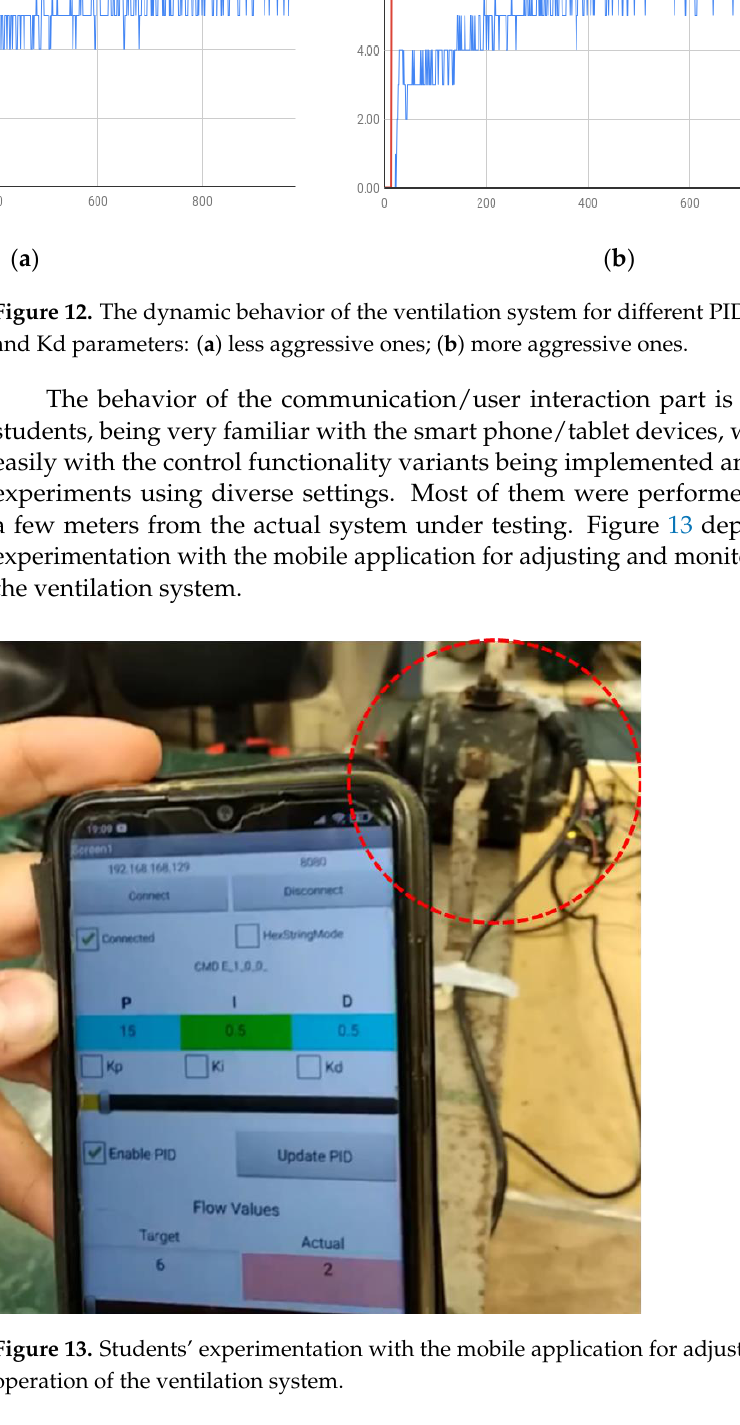
Figure 11. The dynamic behavior of the ventilation control system whose actual performance (blue line) is continuously trying to reach the user-provided target flow level (red line), as captured via the Serial Monitor tool.